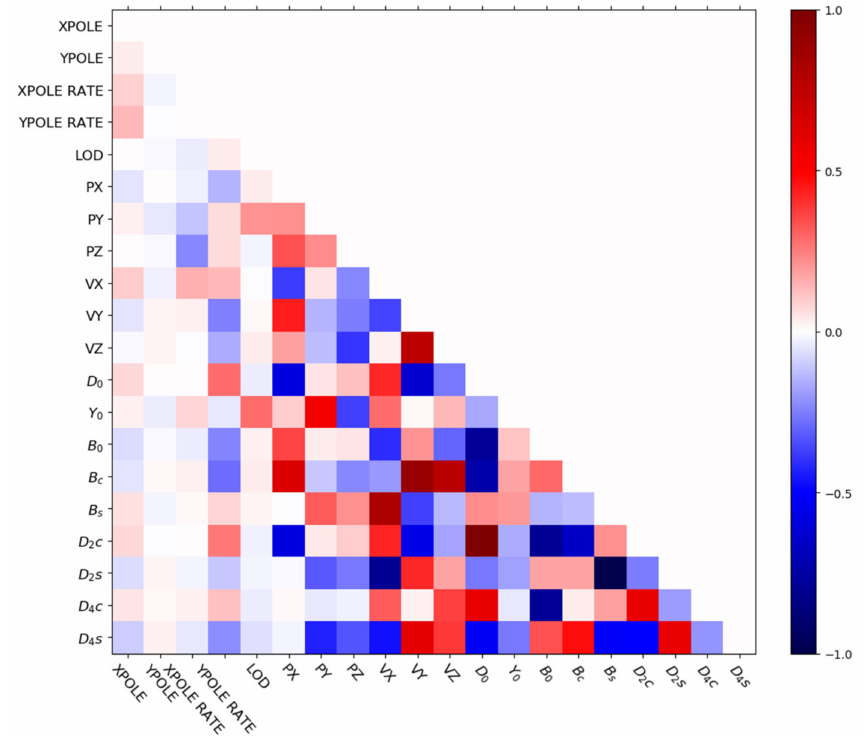
Figure 3. Correlation coefficients between the Earth rotation parameters and the satellite dynamic parameters using the ECOM2 as a parameterization model (E2DYB solution) for G067 (BLOCK IIF) in eclipsing season ( β ≈ − 1.3 ◦ ).